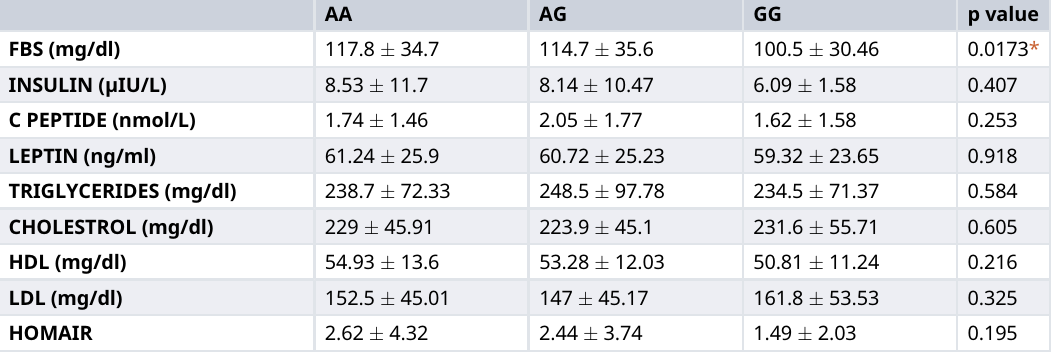
Table 6. Comparison of parameters between three alleles of leptin gene. AA